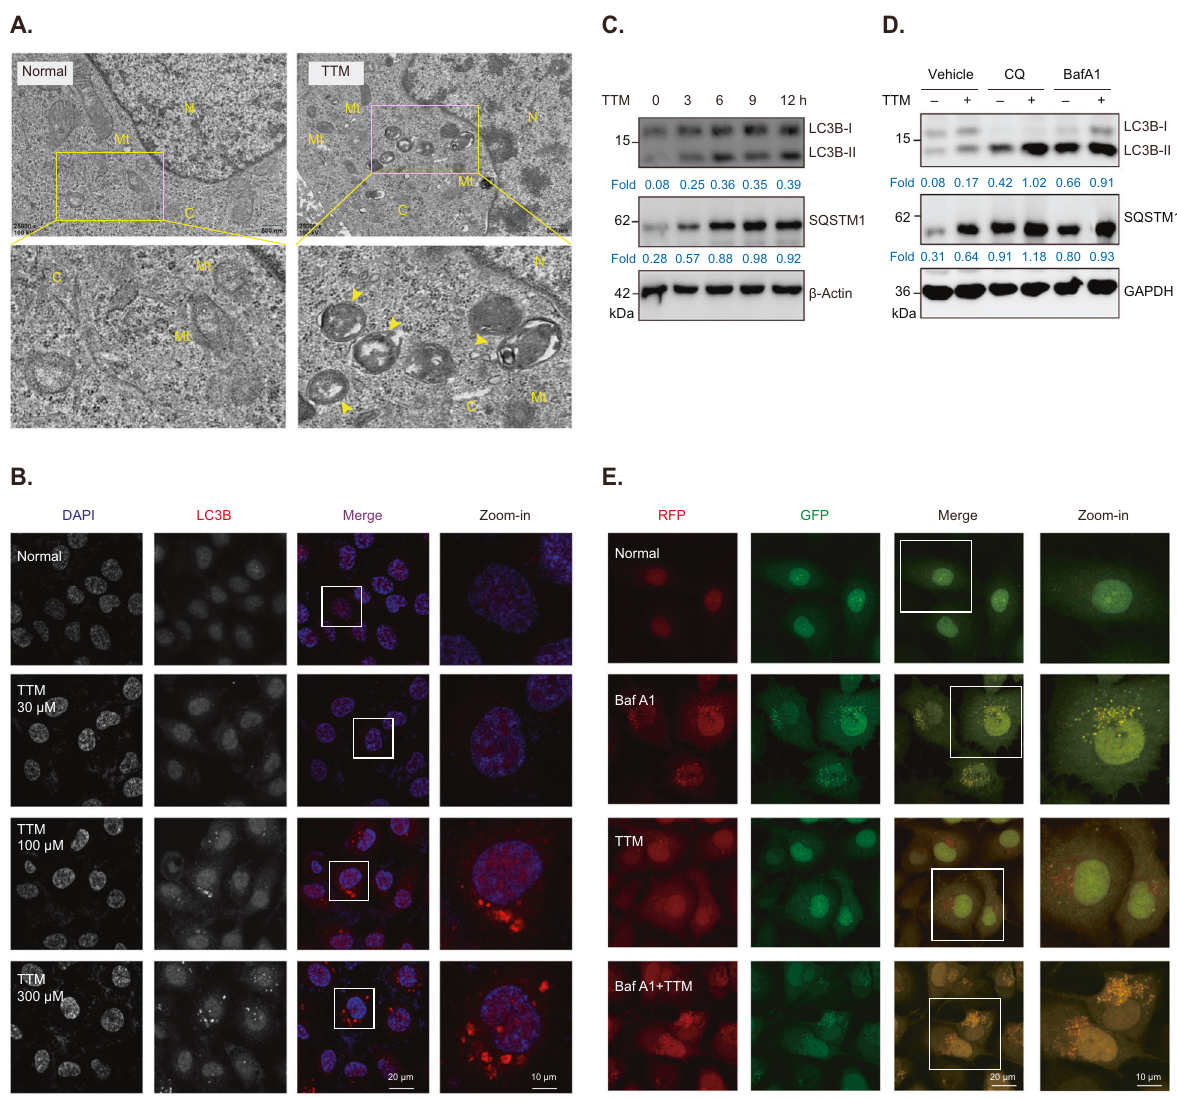
Fig. 3 TTM activates autophagy signaling pathway in HUVECs. A Representative TEM images of TTM-treated HUVECs. Cells were treated with 100 μ M TTM for 12 h. N, nucleus; C, cytoplasm; Mt, mitochondria; Yellow arrow, autophagosomes. B Representative immuno fl uorescence images of LC3B puncta in HUVECs treated with 30, 100, or 300 μ M TTM for 12 h. Scale bar, 20 μ m; Zoom-in scale bar, 10 μ m. C Western blot analysis and quanti fi cation of LC3B and SQSTM1 in HUVECs treated with 100 μ M TTM for 0, 3, 6, 9, and 12 h, respectively. β -Actin was used as loading control. D Western blot analysis and quanti fi cation of LC3B and SQSTM1 in TTM-treated HUVECs with or without lysosome inhibitor CQ (5 μ M) and BafA1 (100 nM), respectively. GAPDH was used as loading control. E Autophagic fl ux assay using tandem fl uorescent-tagged LC3B (RFP-GFP-LC3B) construct. Stable cell line expressing RFP-GFP-LC3B was pretreated with or without Baf A1 for 1 h and then co-incubated with TTM for 12 h. Scale bar, 20 μ m; Zoom-in scale bar, 10 μ